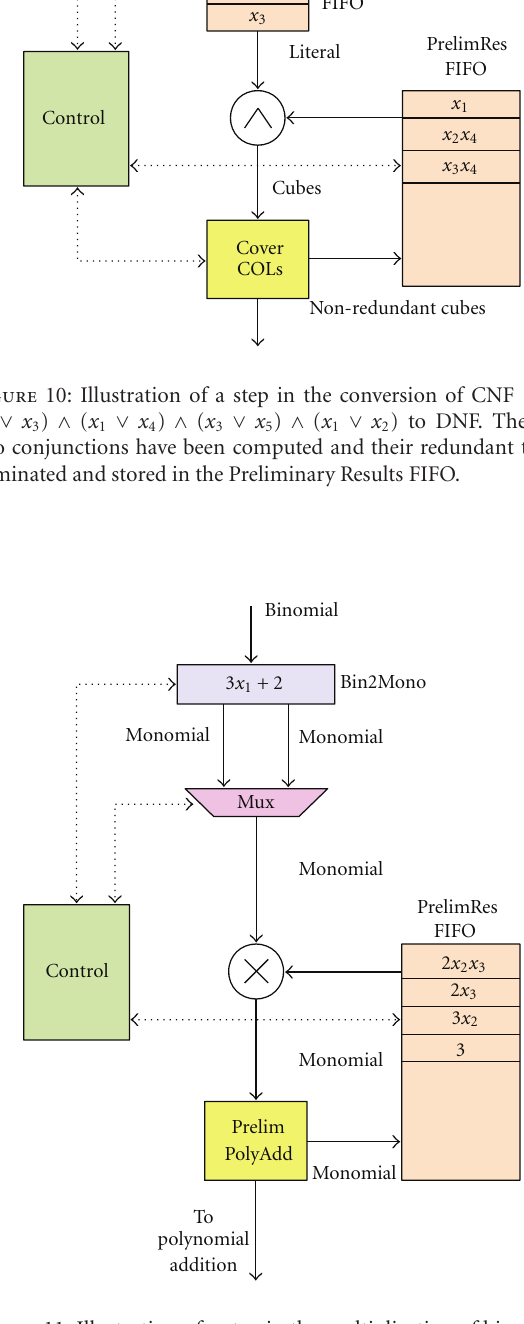
Figure 11: Illustration of a step in the multiplication of binomials ( x 2 + 1)(2 x 3 + 3)(3 x 1 + 2) in Z 5 . The multiplication of the first two binomials has completed and the results are stored in the Preliminary Results FIFO